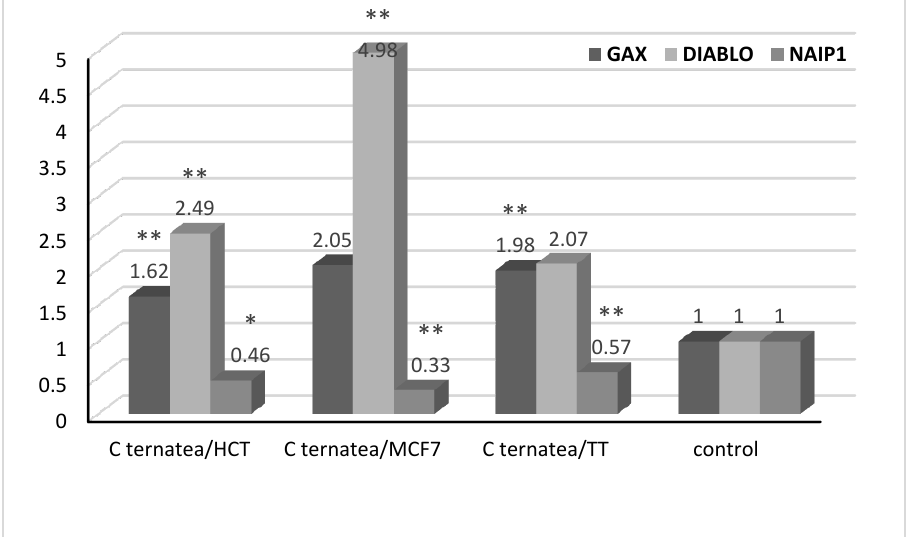
Figure 6. Alterations in the mRNA levels of the GAX, DIABLO, and NAIP1 genes in HCT116, MCF-7, and TT cell lines as a result of medication with the IC50 of C. ternatea extract compared with the control group. The statistically significant variations are indicated by * ( p -value ≤ 0.05) and highly significant variations are implied by ** ( p -value ≤